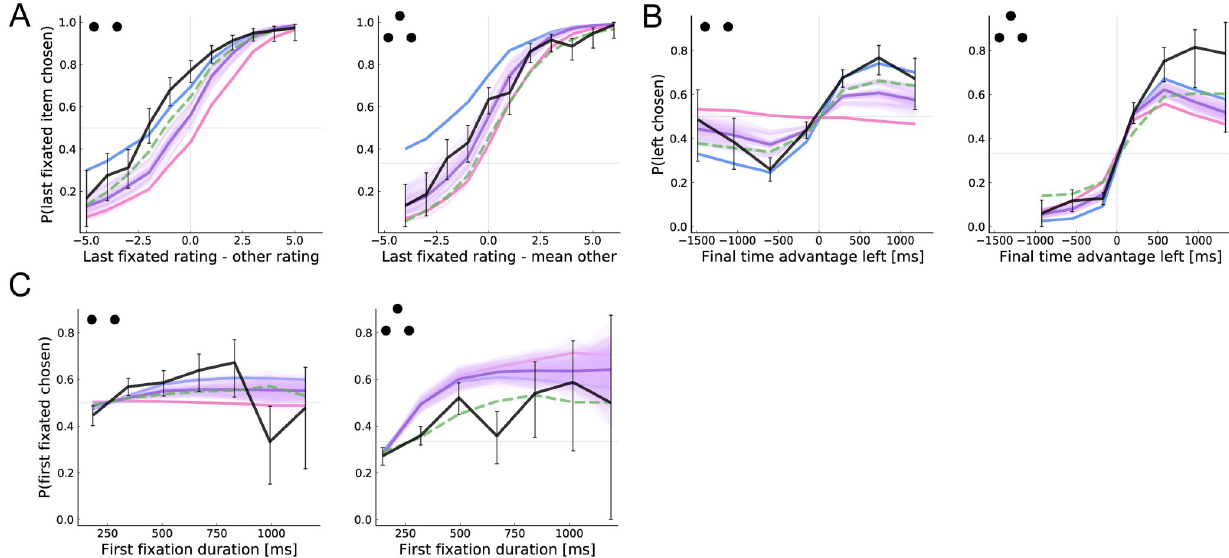
Fig 7. Choice biases. (A) Probability that the last fixated item is chosen as a function of its relative rating. (B) Probability that the left item is chosen as a function of its final fixation advantage, given by total fixation time to the left item minus the mean total fixation time to the other item(s). (C) Probability of choosing the first-seen item as a function of the first-fixation duration. See Fig 3 for more details.